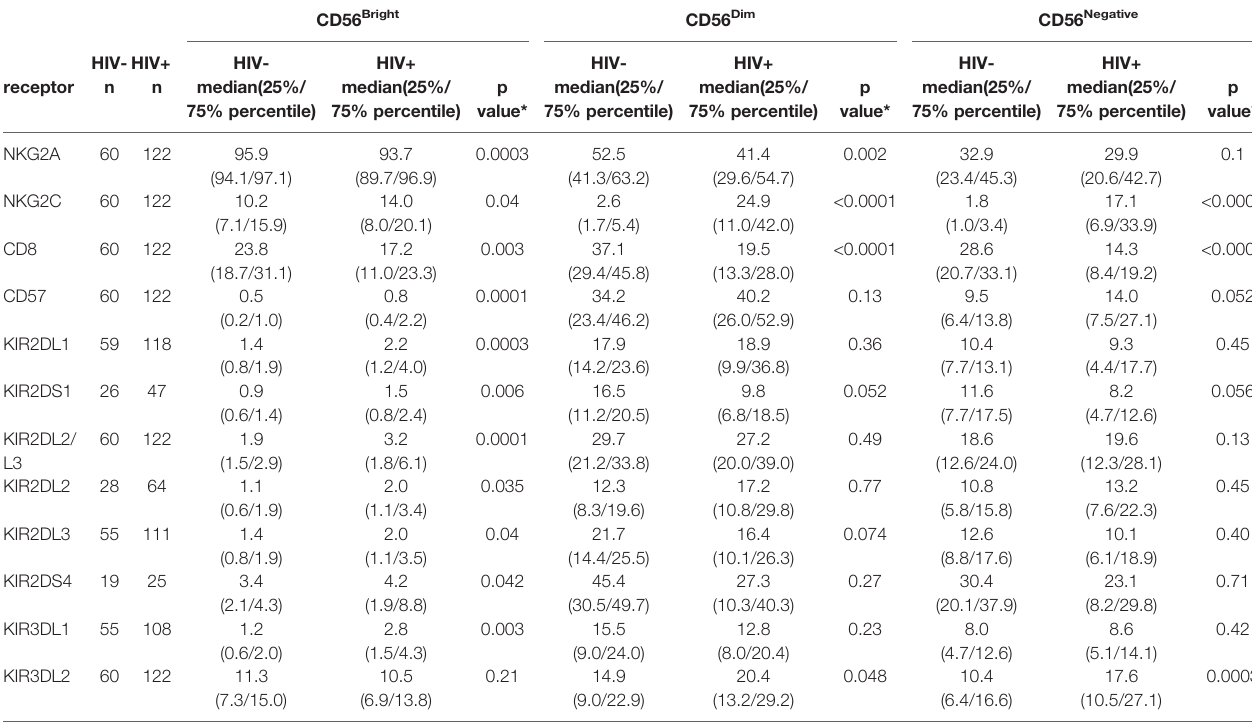
TABLE 4 | NK cell receptor expression in NK cell